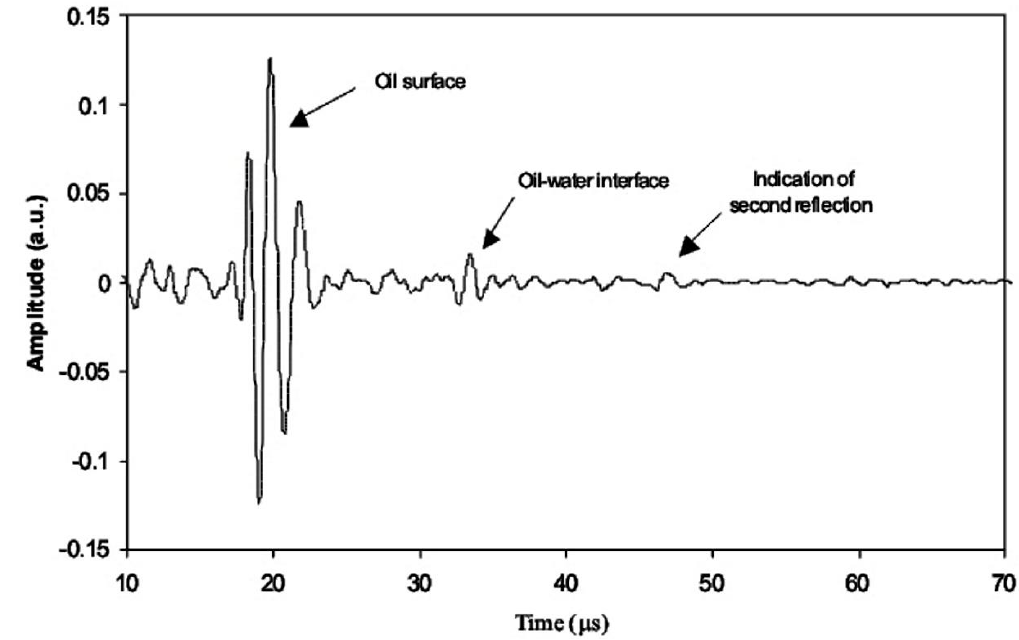
Figure 6 . The signal from a 3-laser thickness sensor. The time of the first return pulse corresponds to a thickness of about 6 mm. This was measured by a prototype sensor mounted in an aircraft and flying over containers with various thicknesses of oil on water.